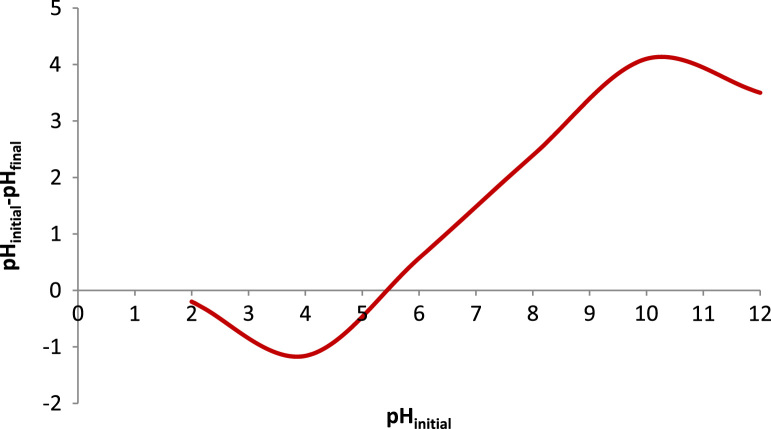
Variation of pH (pHinitial – pHfinal) versus initial pH for determining the adsorbent pHzpc.